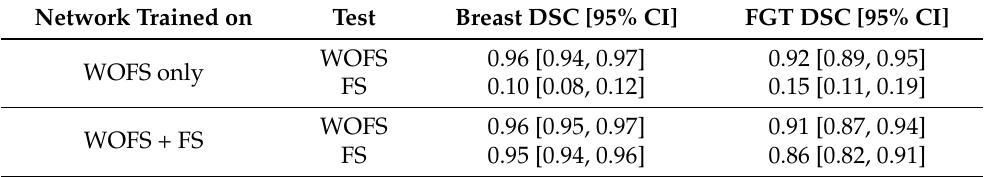
Table 3. Internal test set results (n = 9 patients, 18 acquisitions (9 WOFS, 9 FS)). Breast and FGT Dice Similarity Coefficients (DSC) and 95% Confidence Intervals (CI) from network trained only without fat suppression (WOFS only) acquisitions and without and with fat suppression acquisitions (WOFS + FS).